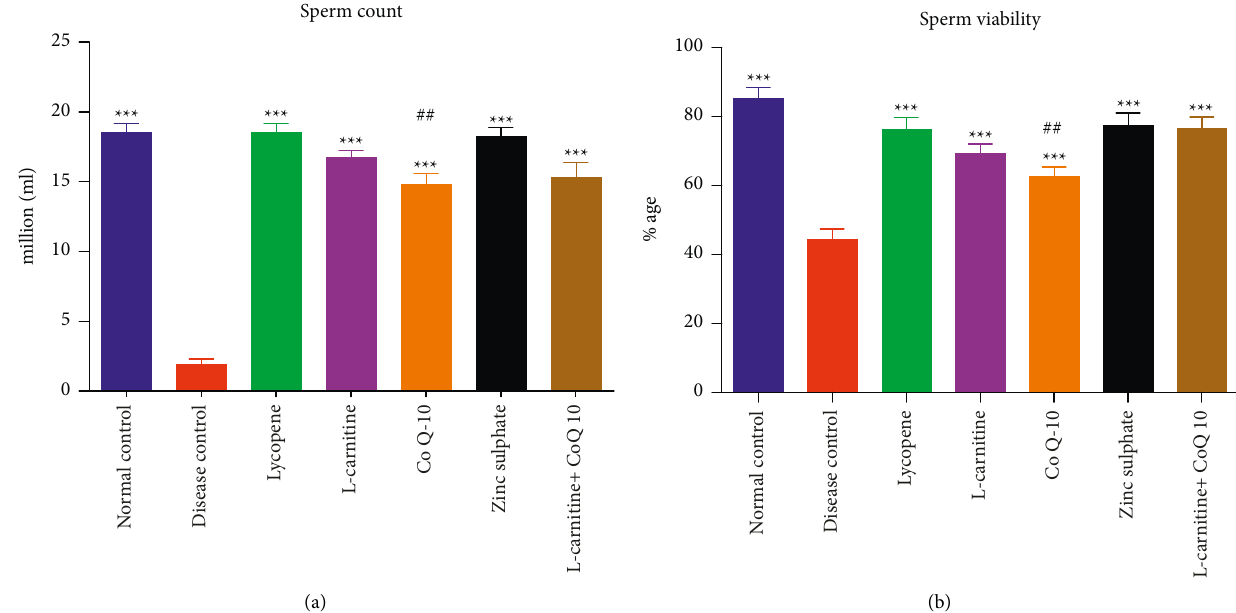
Figure 1: Effectof lycopene,L-carnitine,coenzyme Q10,and zincsulfateonspermcount andviabilityof cadmium-exposedrats. Resultspresentedas mean ± S.D. ( n � 10). ∗∗∗ and ## showed statistically significant as compared to disease control and normal control at P < 0.001 and P < 0.01